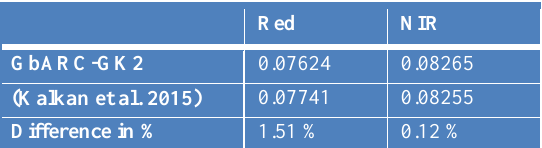
Table 2. The gain values for Göktürk-2 red and NIR bands The comparative analysis of NDVI values for both Landsat 8 and Göktürk-2 imageries is examined by using 24 random points which are selected from vegetated area of the images. The comparative NDVI results of Landsat 8, Göktürk-2 -in which GbARC-GK2 gain parameter is used- and Göktürk-2 -in which (Kalkan et al. 2015) gain parameter is used-are presented in Figure 4. It must be noticed that Landsat 8 and Göktürk-2 acquired in different days (one day between). Therefore, this temporal difference can play an important role in NDVI differences.